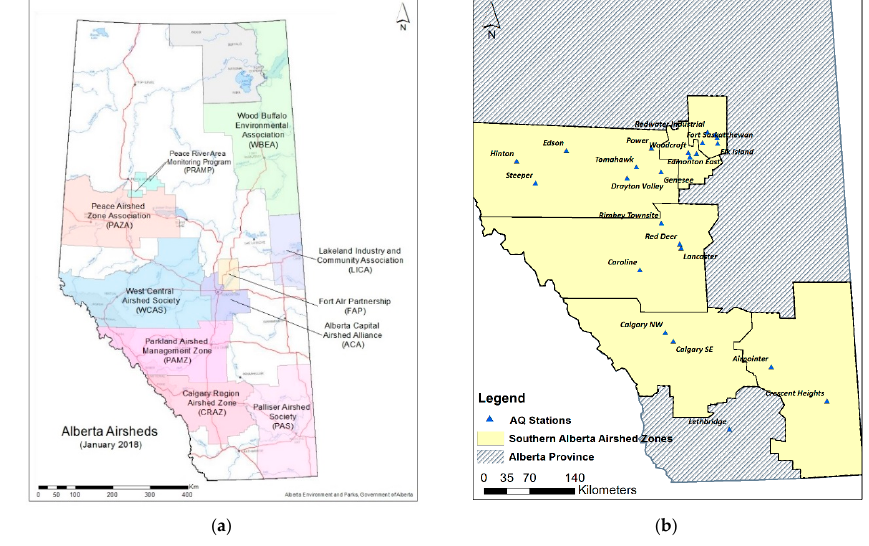
Figure 1. Alberta airshed zones ( a ) (www.albertaairshedscouncil.ca), Distribution of 24 monitoring stations in the Southern Alberta airshed zones used in the present study ( b ).